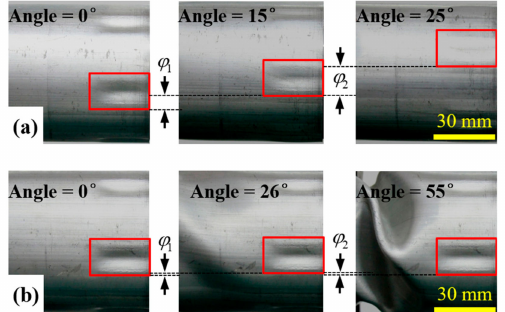
Figure 7. Torsional process of the joint: ( a ) failure mode 1 (the discharge energy of 12 kJ), and ( b ) failure mode 2. (the discharge energy of 16